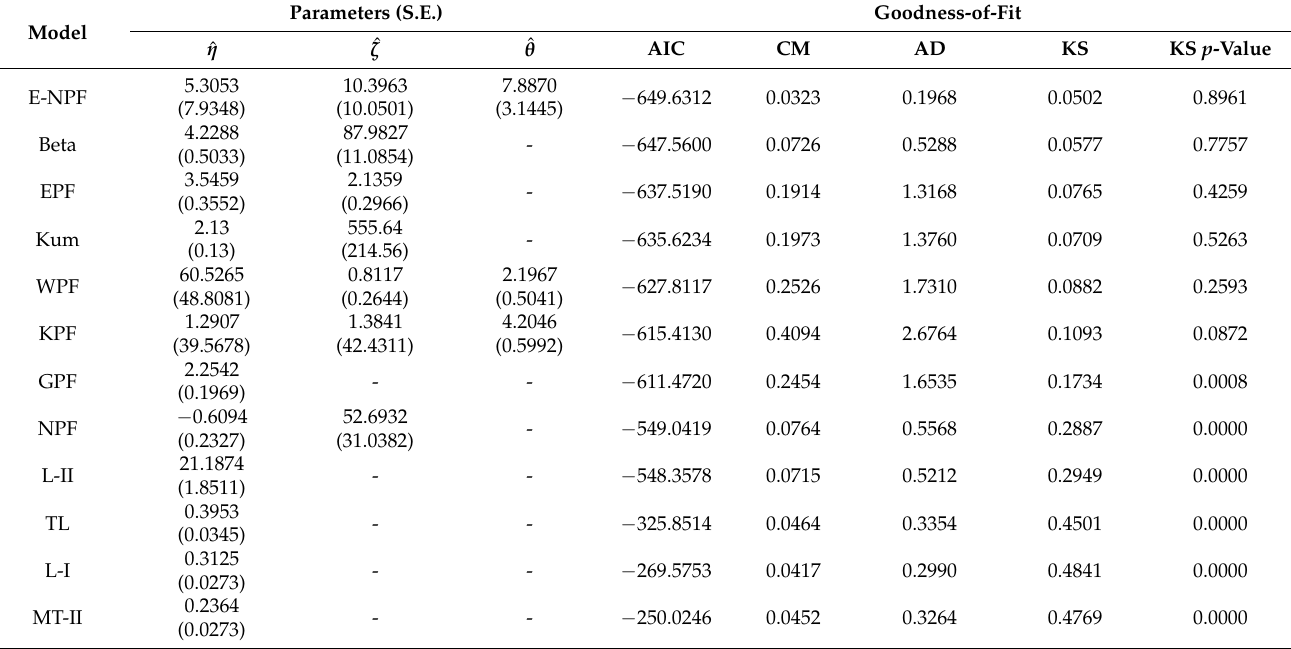
Table 10. Parameter estimates, S.E., and information criterion for SAR image modeling data.